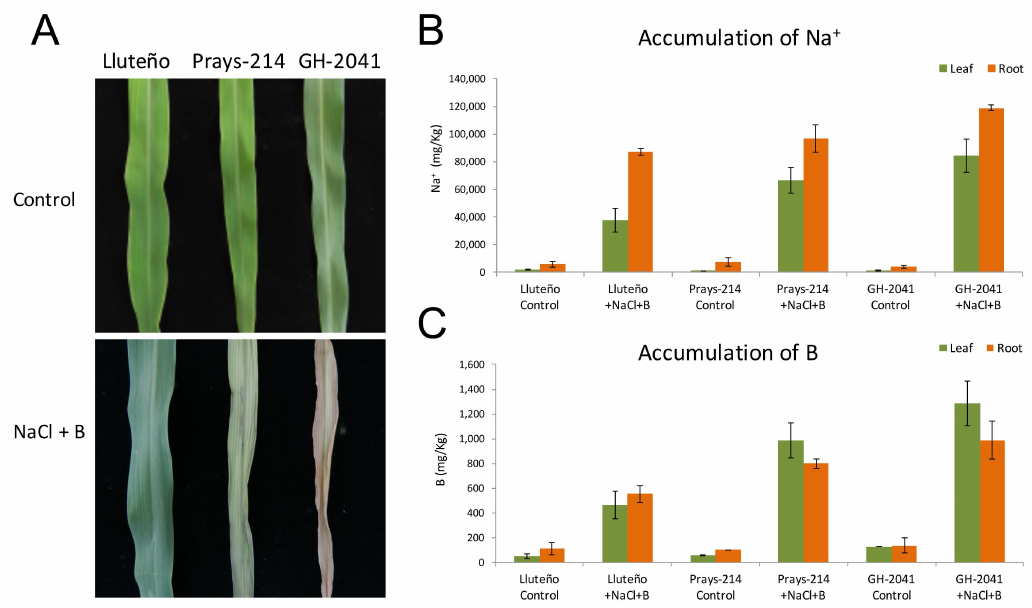
Figure 1. Responses of Lluteño maize to salinity and boron stress. ( A ) differential responses of Lluteño and the commercial hybrids Prays-214 and GH-2041 seedling to salinity and boron stress after 10 days; ( B ) Na + accumulation of Lluteño maize seedling under 150 mM NaCl and 20 ppm B; and ( C ) B accumulation of Lluteño maize seedling under 150 mM NaCl and 20 ppm